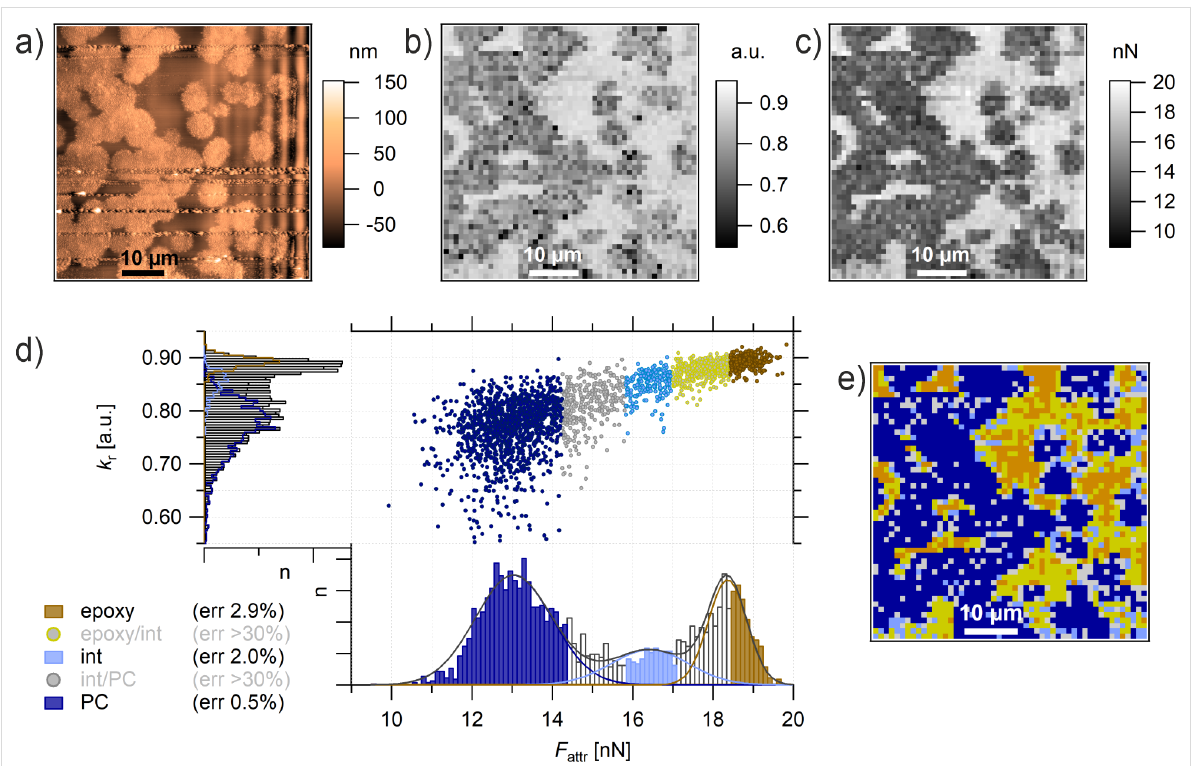
Figure 4: (a) AFM tapping-mode topography. PC and epoxy phases can be distinguished by the height difference. (b) k r and (c) F attr AFM FDC maps (60 × 60 points). (d) Property domain of the AFM FDC measurement with the k r histogram (top left), F attr histogram (bottom right) and k r / F attr diagram (top right). The k r histogram is deconvoluted with three Gaussian fits assigning the chemical structures to epoxy (brown) and PC (blue) and an inter- mediate behavior (int, light blue) to the measuring points (error <3%). Measuring points which a larger error (>30%) are found between the epoxy and int (grey yellow) or between int and PC (grey) (see also the k r / F attr diagram, top-right panel). (e) mPCA: results of the property domain are shown in the spatial domain. The measurements were performed with the tip